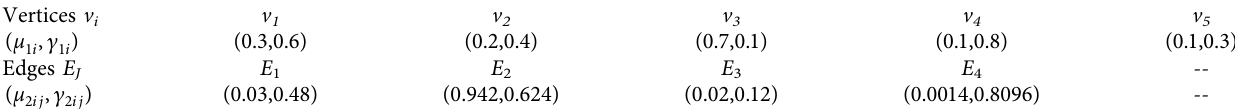
Table 11: Degree of membership and nonmembership values for vertices and edges of Figure